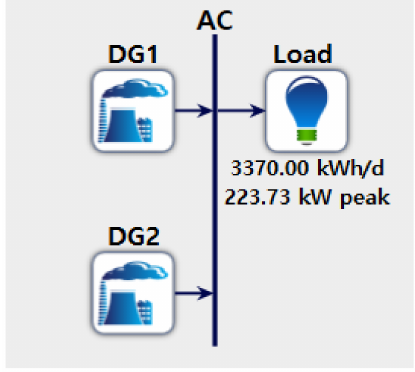
Figure 4. Microgrid topology_A in